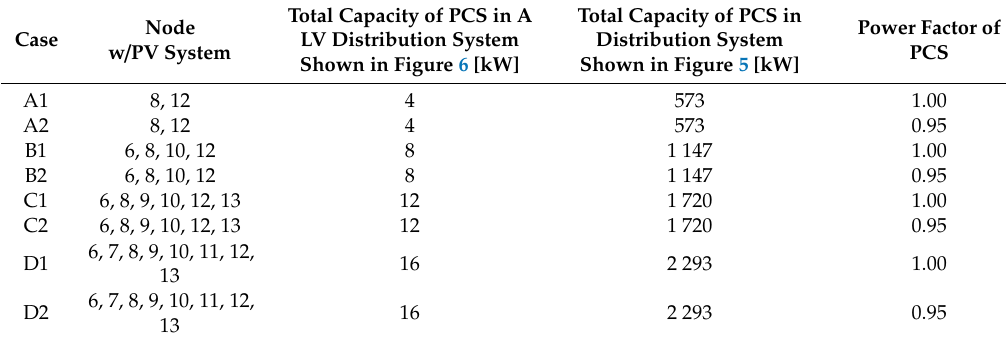
Table 3. Case of interconnections of PCS.